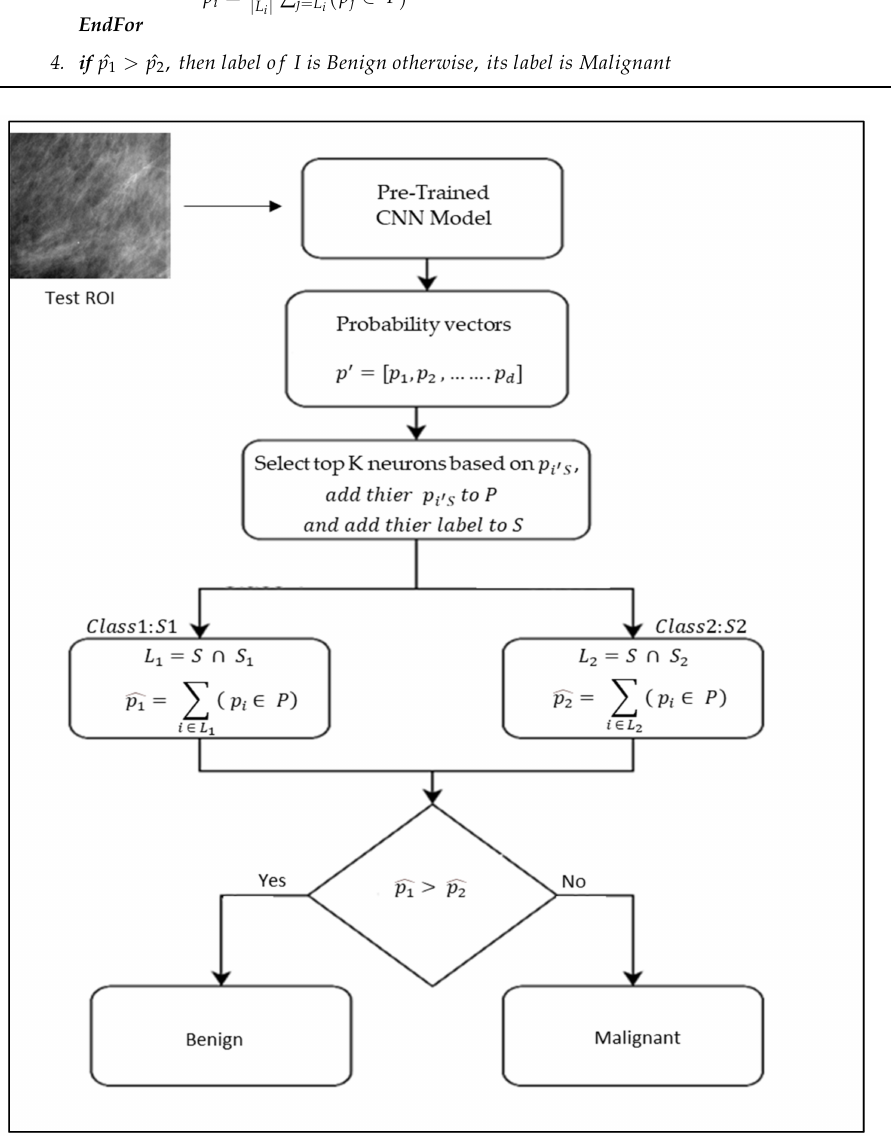
Figure 2. The flow chart of the testing